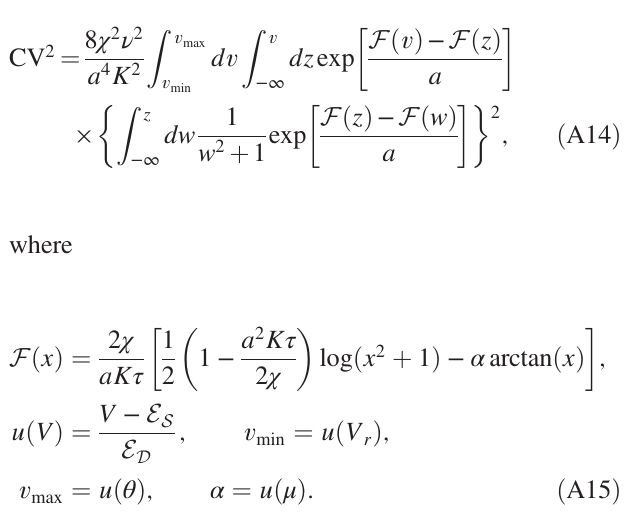
p ffiffiffiffiffiffiffiffiffiffiffiffiffi a 2 K= χ . Note that the minimum amplitudes of drift and